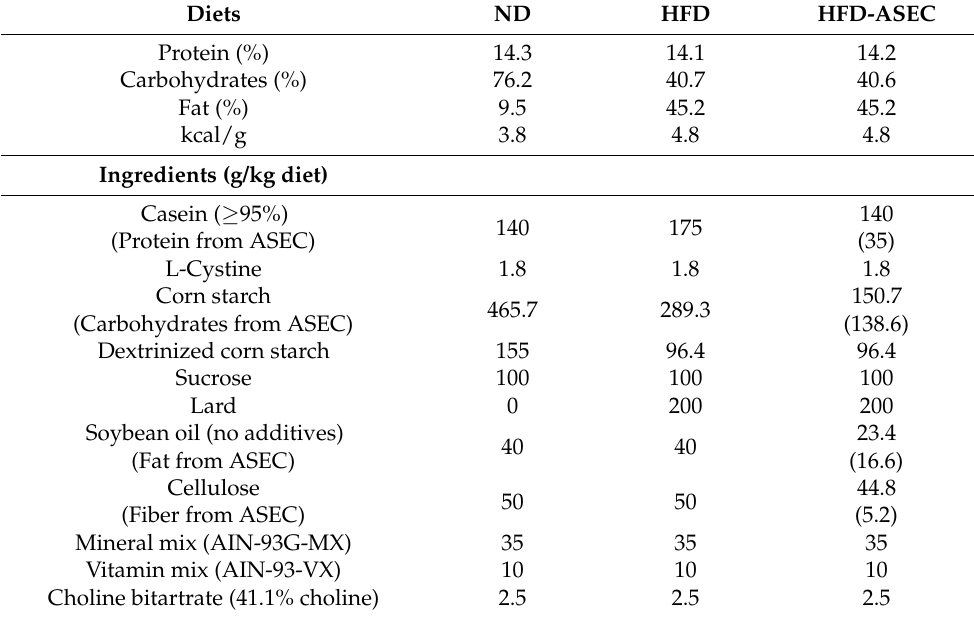
Table 1. Compositions of the experimental